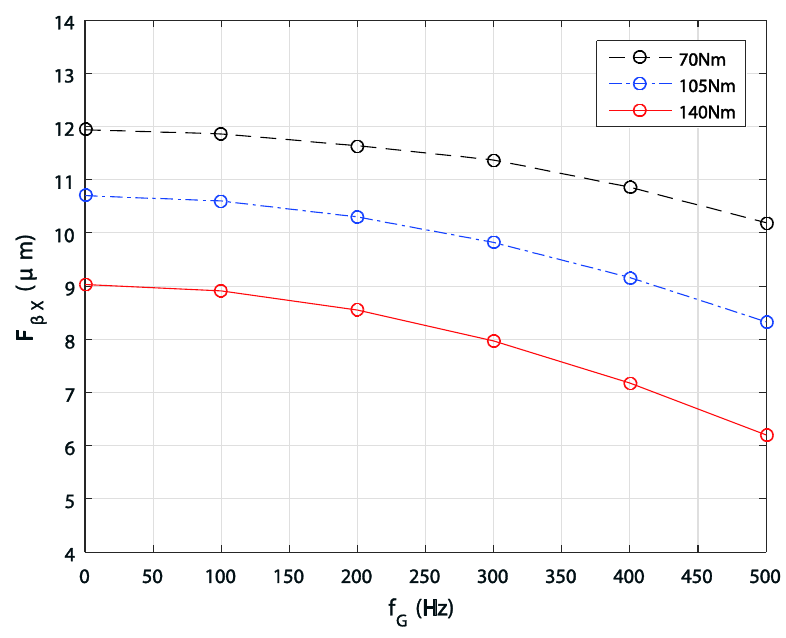
Appl. Sci. 2018 , 8 , x FOR PEER REVIEW Figure 8. Gear mesh misalignment,